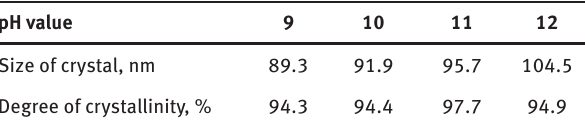
Table 4: Effect of reaction temperature on size and crystal degree of HA.